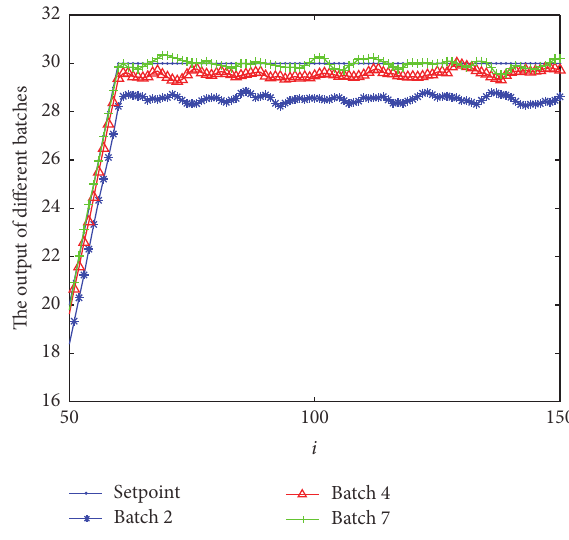
Figure 3: The controlled